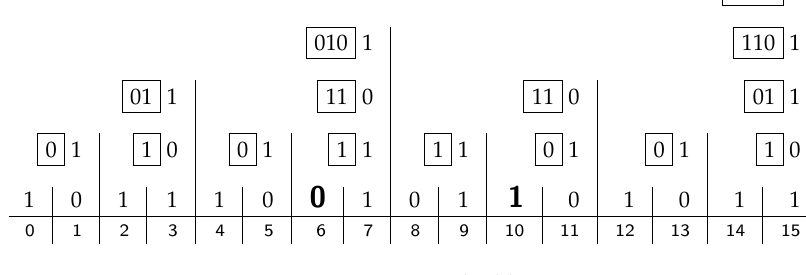
Figure 5. Detecting a double